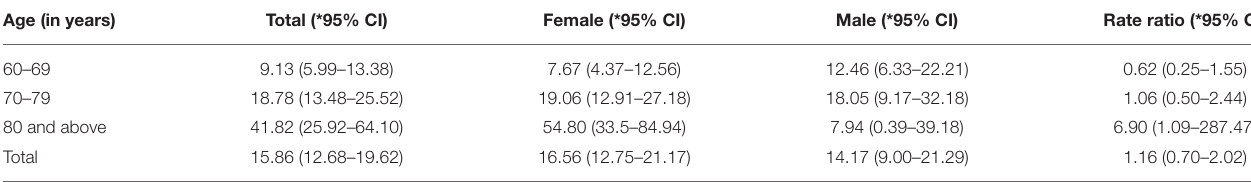
TABLE 3 | Age and gender-specific incidence rate for dementia (per 1,000 person-years).